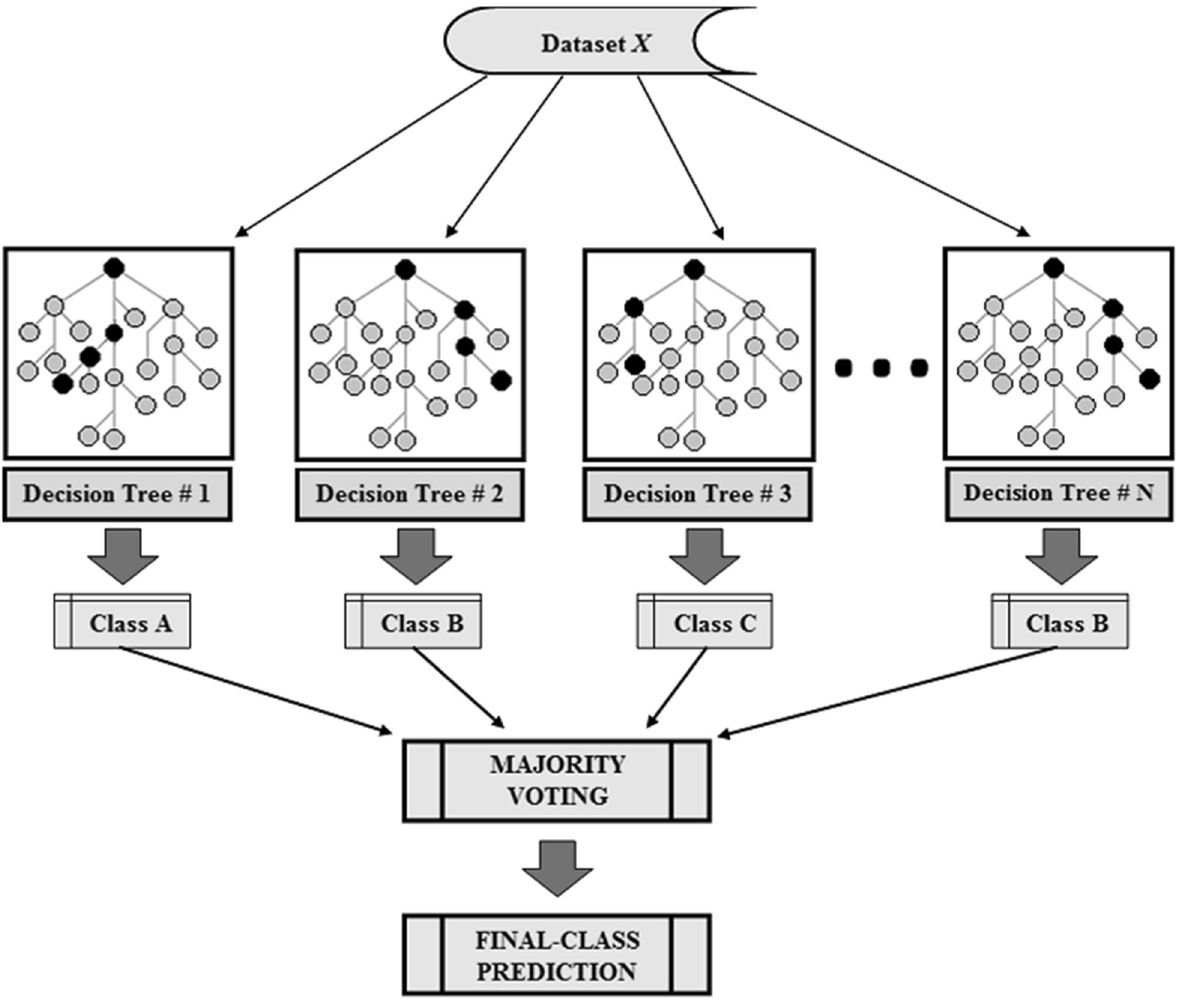
Figure 7. The structure of the random forest